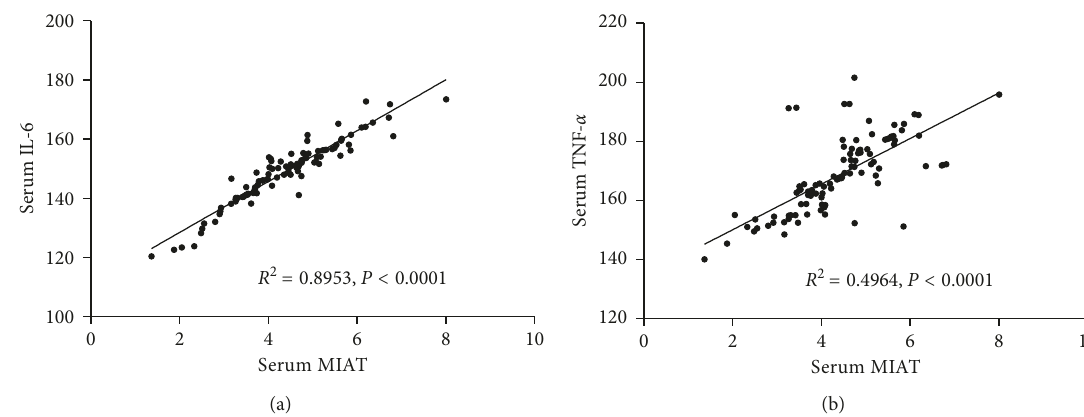
Figure 3: Relationship between serum MIAT and serum IL-6 and TNF- α . Risk factors for CAD. Table 2: Multivariate analysis of independent risk factors for CAD. Feature